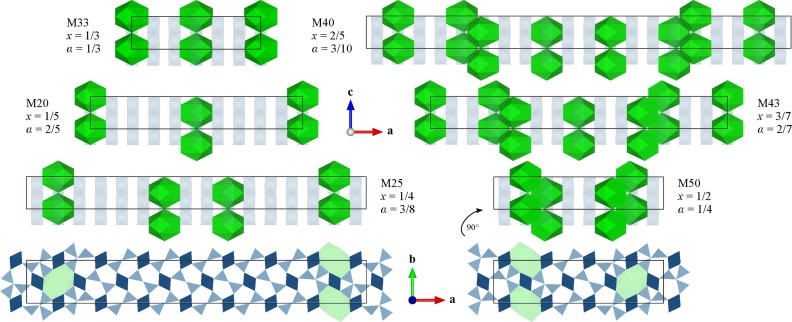
Vacancy distribution patterns of selected mullite supercells. The oxygen coordination spheres of vacancies are shown in green. In views along b tetrahedra are neglected for clarity and octahedral chains are shown with decreased opacity. Views parallel to c show slabs of the models of M25 (bottom left) and M50 (bottom right). AlO6 octahedra are shown in dark blue. Each tetrahedral site is a potential site for Si, but in this figure Al and Si are not distinguished.